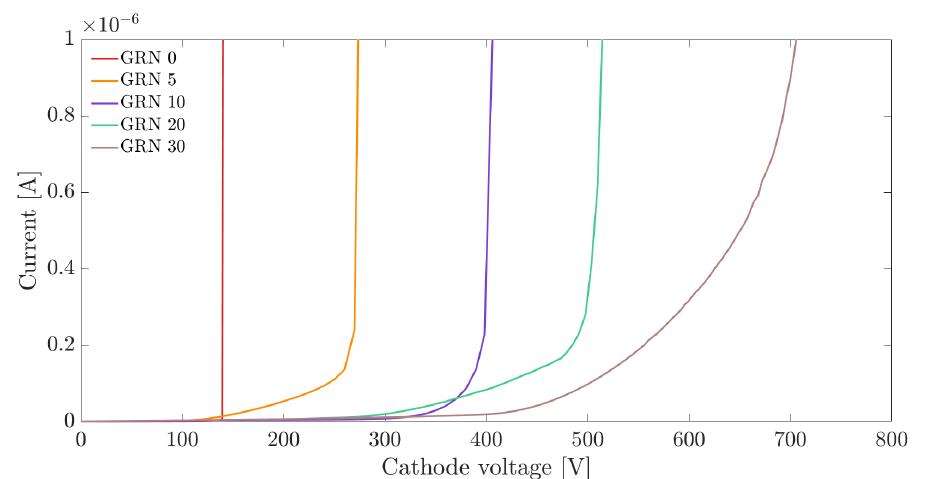
Figure 7. Test diode currents as a function of the applied cathode voltage measured on diodes with different number of guard rings (GRN) and 6 µ m